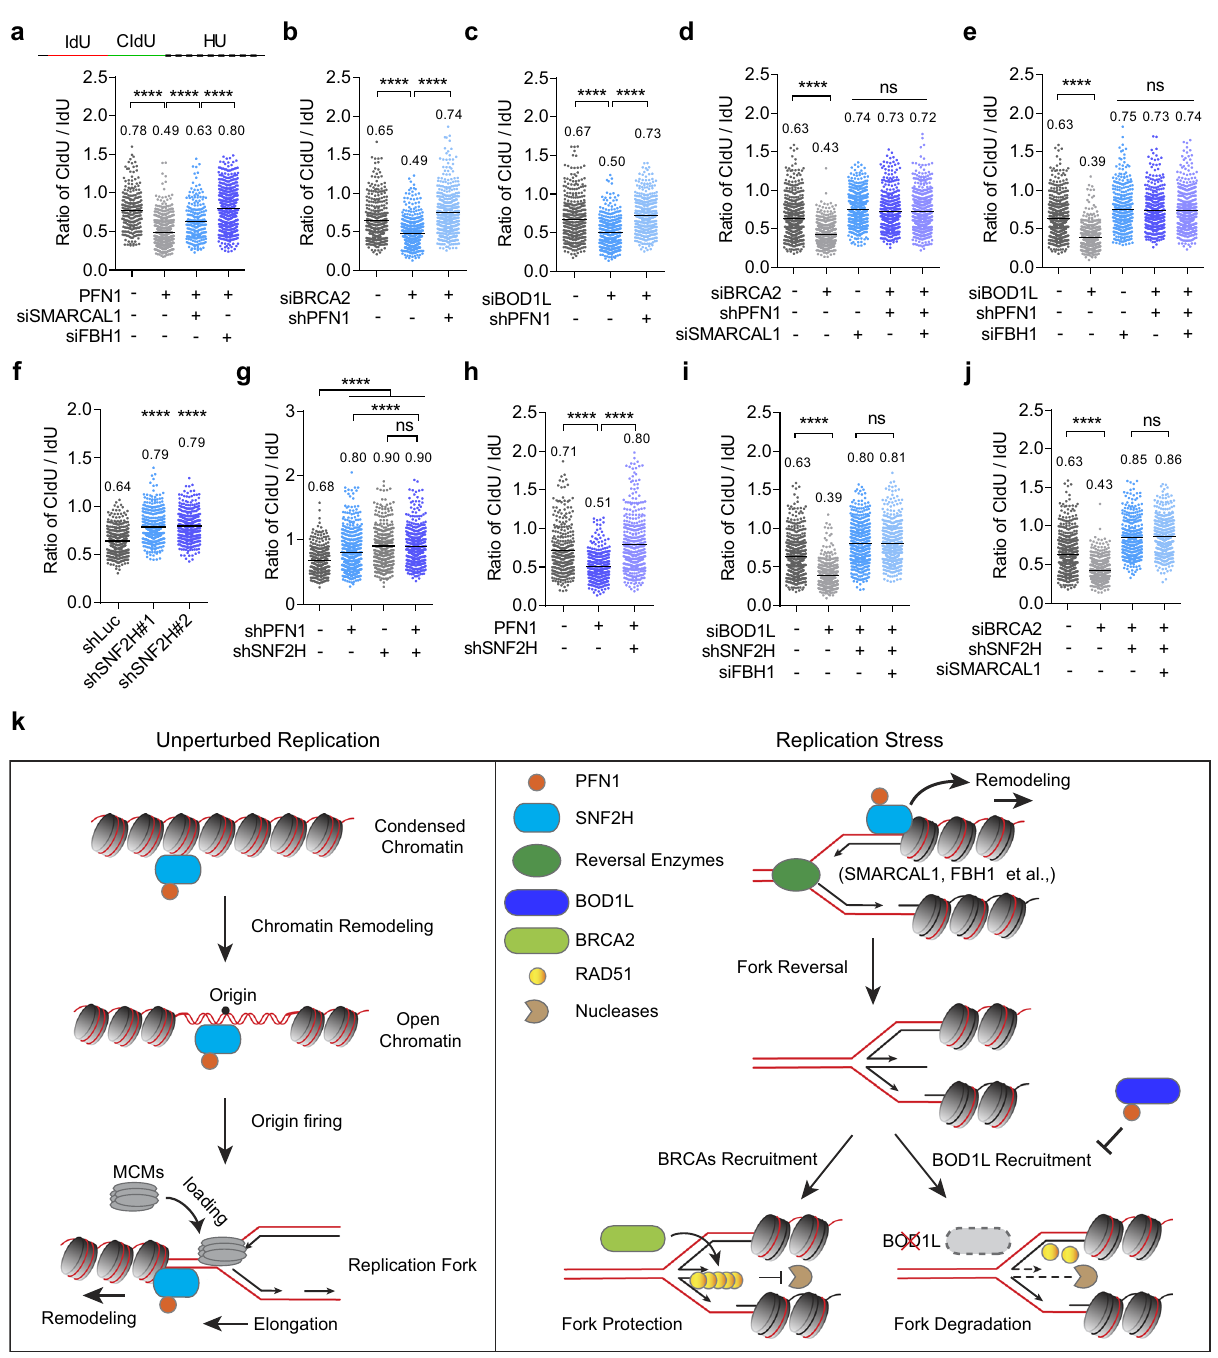
Fig.7|DegradationofstressedforksrequiresPFN1andSNF2H.a RatiosofCIdU/ IdU tract lengths in control or PFN1-overexpressing HeLa cells transfected